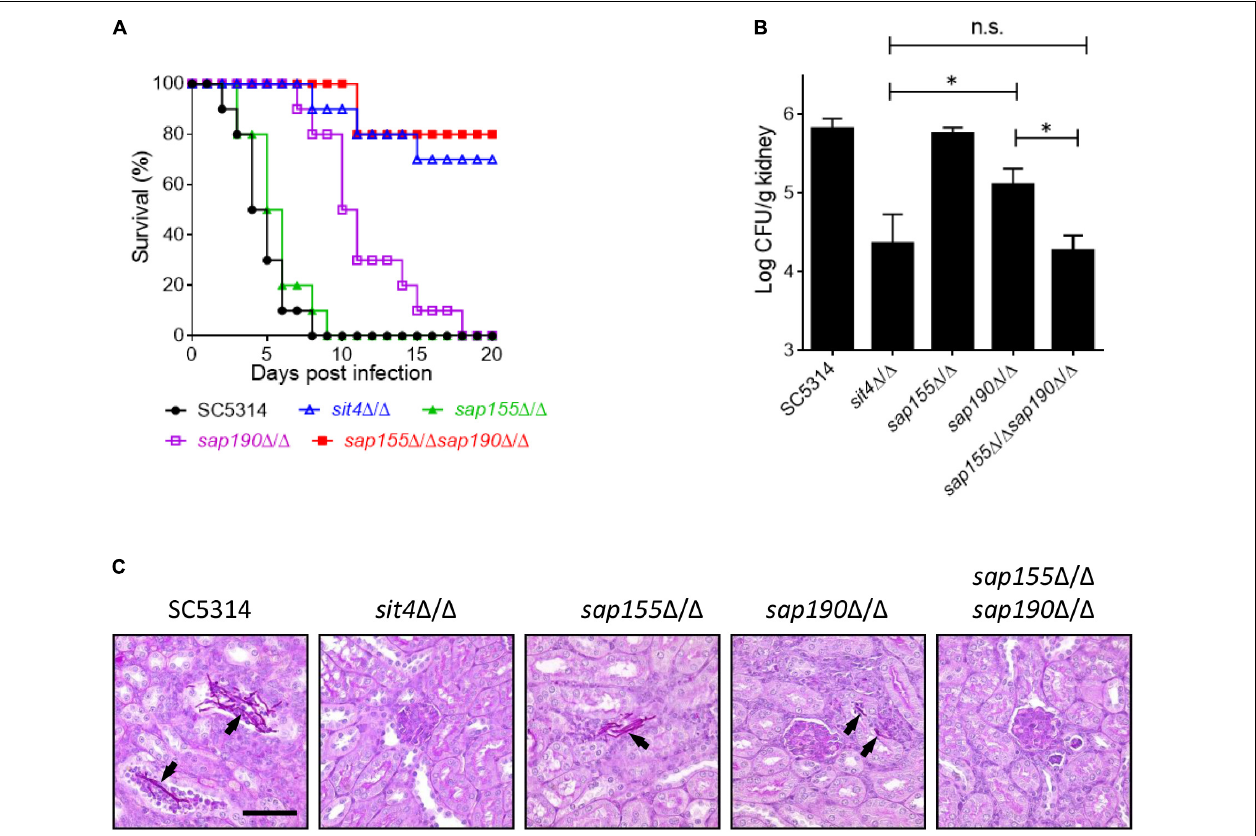
FIGURE 6 | The virulence of sit4 (cid:49) / (cid:49) , sap155 (cid:49) / (cid:49) , sap190 (cid:49) / (cid:49) , and sap155 (cid:49) / (cid:49) sap190 (cid:49) / (cid:49) mutants in a murine model of disseminated candidiasis BALB/c mice were injected via the tail vein with 10 6 yeast cells of SC5314, sit4 (cid:49) / (cid:49) , sap155 (cid:49) / (cid:49) , sap190 (cid:49) / (cid:49) , or sap155 (cid:49) / (cid:49) sap190 (cid:49) / (cid:49) strains (15 mice per C. albicans strain) and monitored for (A) survival over a period of 20 days. The results of survival curves were analyzed using Kaplan-Meier test. The statistical analysis showed that the survival curves of sap190 (cid:49) / (cid:49) strain are significantly different compared to SC5314 or sap155 (cid:49) / (cid:49) strain, and the survival curves of sit4 (cid:49) / (cid:49) or sap155 (cid:49) / (cid:49) sap190 (cid:49) / (cid:49) strain are significantly different compared to SC5314, sap155 (cid:49) / (cid:49) , or sap190 (cid:49) / (cid:49) strain. Five mice were sacrificed after 48 h of the injection to (B) determine the fungal load in the kidney (the results of fungal burdens were analyzed with Mann-Whitney test. ∗ p < 0.05 compared between the indicated two groups. n.s: no significance) and (C) conduct histological examinations of kidney sections. Size bars = 0.13 mm. Arrows indicate C. albicans cells in the renal